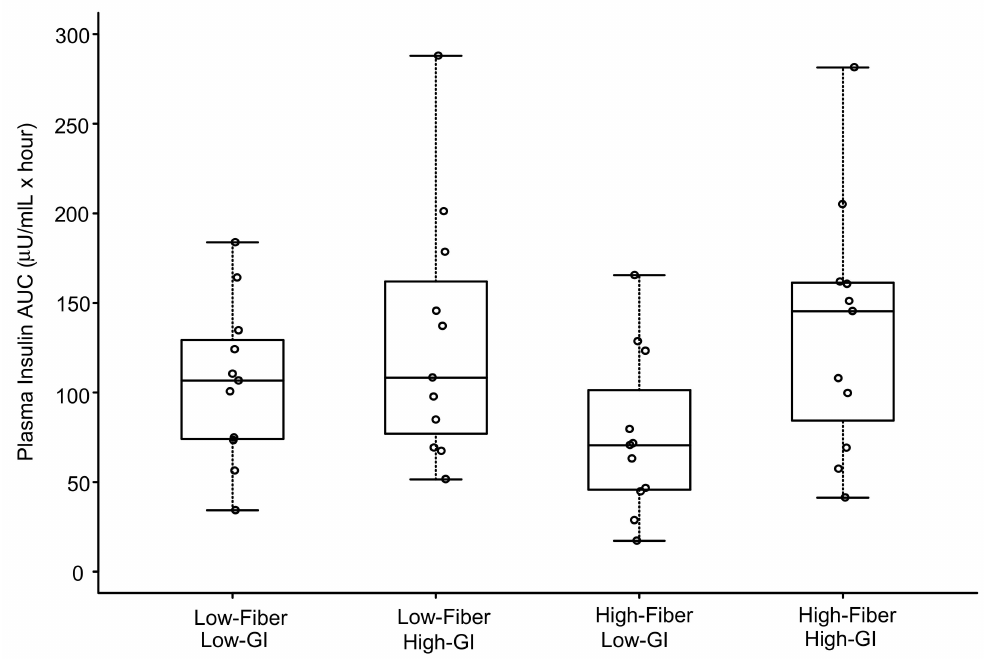
Figure 5. Plasma insulin area under curve (AUC) over 4 h in response to four meals di ff ering in glycemic index (GI) and fiber content. Boxes for each meal represent the interquartile range. Minimum and maximum values are indicated at the tips of each vertical line. The median for each meal is depicted by the horizontal line within each box. See Table 5 for statistical comparisons between